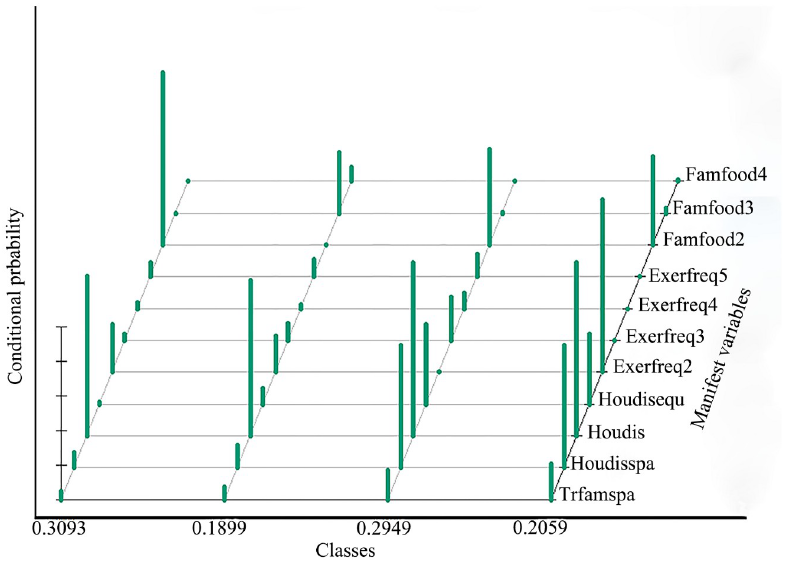
Fig 4. Posterior probability of manifest variable responses across each class. Notes : Trfamspa, transformation of family space; Houdisspa, household disinfection space; Houdisequ, household disinfection equipment; Houdis, household disinfection; Exerfreq2, exercise frequency (1~2 sessions/week); Exerfreq3, exercise frequency (3~4 sessions/week); Exerfreq4, exercise frequency (5~6 sessions/week); Exerfreq5, exercise frequency (one sessions/day); Famfood2, rationing specific basic supplies; Famfood3, family food shortage; Famfood4, no family food reserves.